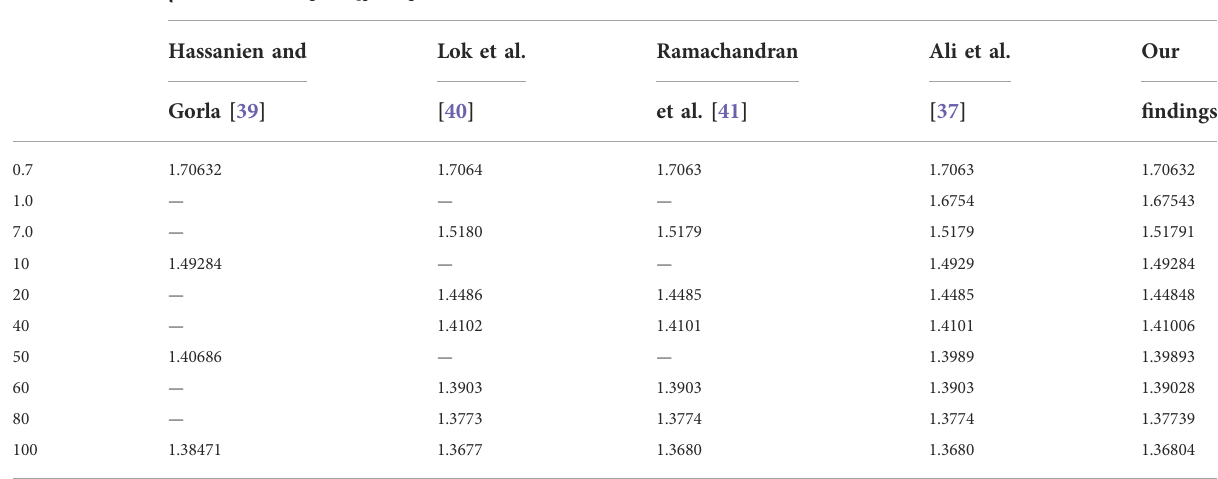
TABLE 1 Numerical evaluations for f 99 (0) with fl uctuation in Pr . Pr